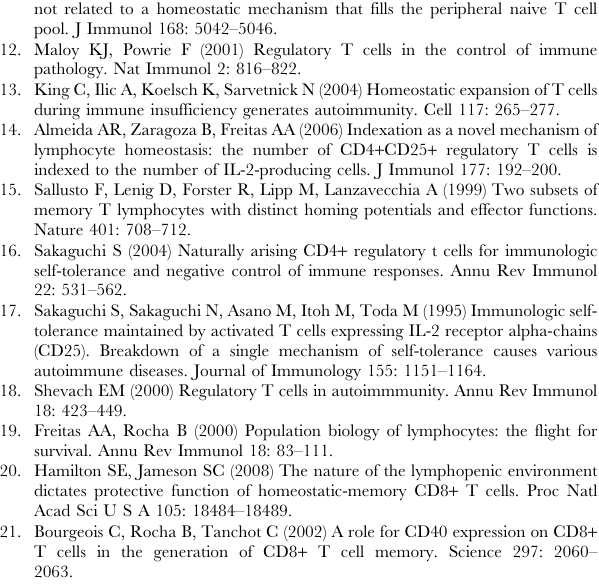
Figure S3 Expansion of CD8 + CD40 2 / 2 T cells. ( A ) The absolute number of CD8 + T cells recovered 8 weeks after 2 6 10 4 CD8 + T cells from WT or CD40 2 / 2 donors were transferred alone or with CD4 T cells into CD3 e 2 / 2 mice. The increased accumulation of CD8 + T cells was observed regardless of whether these cells were able to express CD40. ( B ) Control of the growth of the CD4 + T cells in CD40 2 / 2 hosts. CD4 + T cell recovery 10 weeks after the of the transfer of 2 6 10 4 CD4 + T cells co-injected with WT or CD40 2 / 2 donor T cells into CD3 e 2 / 2 or CD40 2 / 2 CD3 e 2 / 2 hosts. Note that CD4 + T cell expansion still occurred in the absence of CD40. Results are from two pooled experiments. Statistically significant differences are shown (* p # 0.05; *** p , 0.001). Figure S4 Help in RAG 2 / 2 host mice. The absolute number of CD8 + T cells recovered 7 weeks after 2 6 10 4 CD8 + T cells were transferred alone or with CD4 T cells into CD3 e 2 / 2 or RAG 2 / 2 hosts. The helper effect was observed in the presence or absence of B cells. Statistically significant differences are shown (*** p , 0.001).